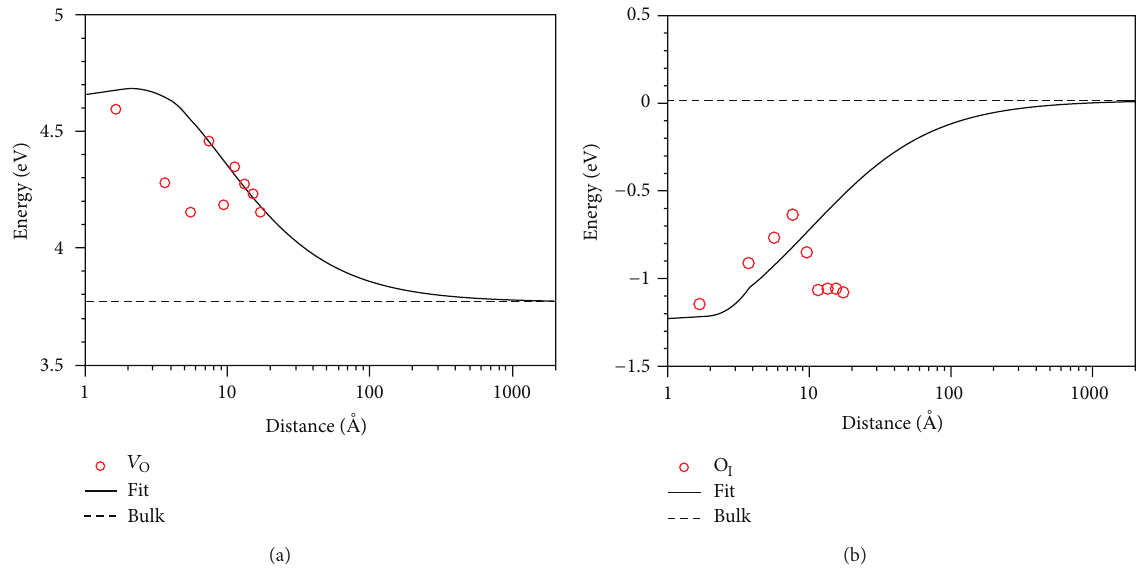
Figure 4: O defect formation energies for near surface and in the bulk UO 2 with LDA, as well as the fitting curve (a) O vacancy and (b) O interstitial, corresponding defect formation energies in the bulk UO 2 .